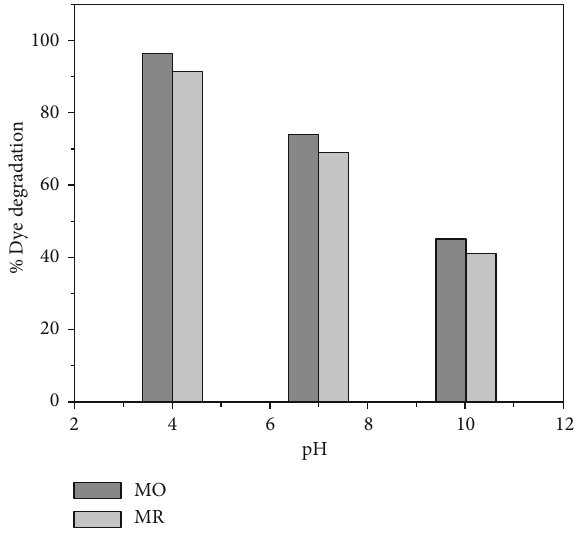
O @SiO @Ru HMCs. 3 4 2